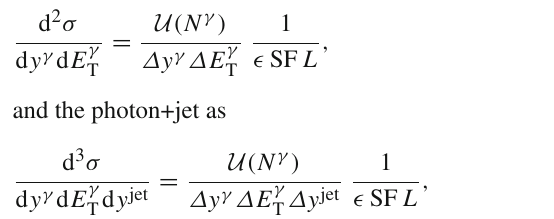
ties, is roughly 5%. The uncertainties of the event